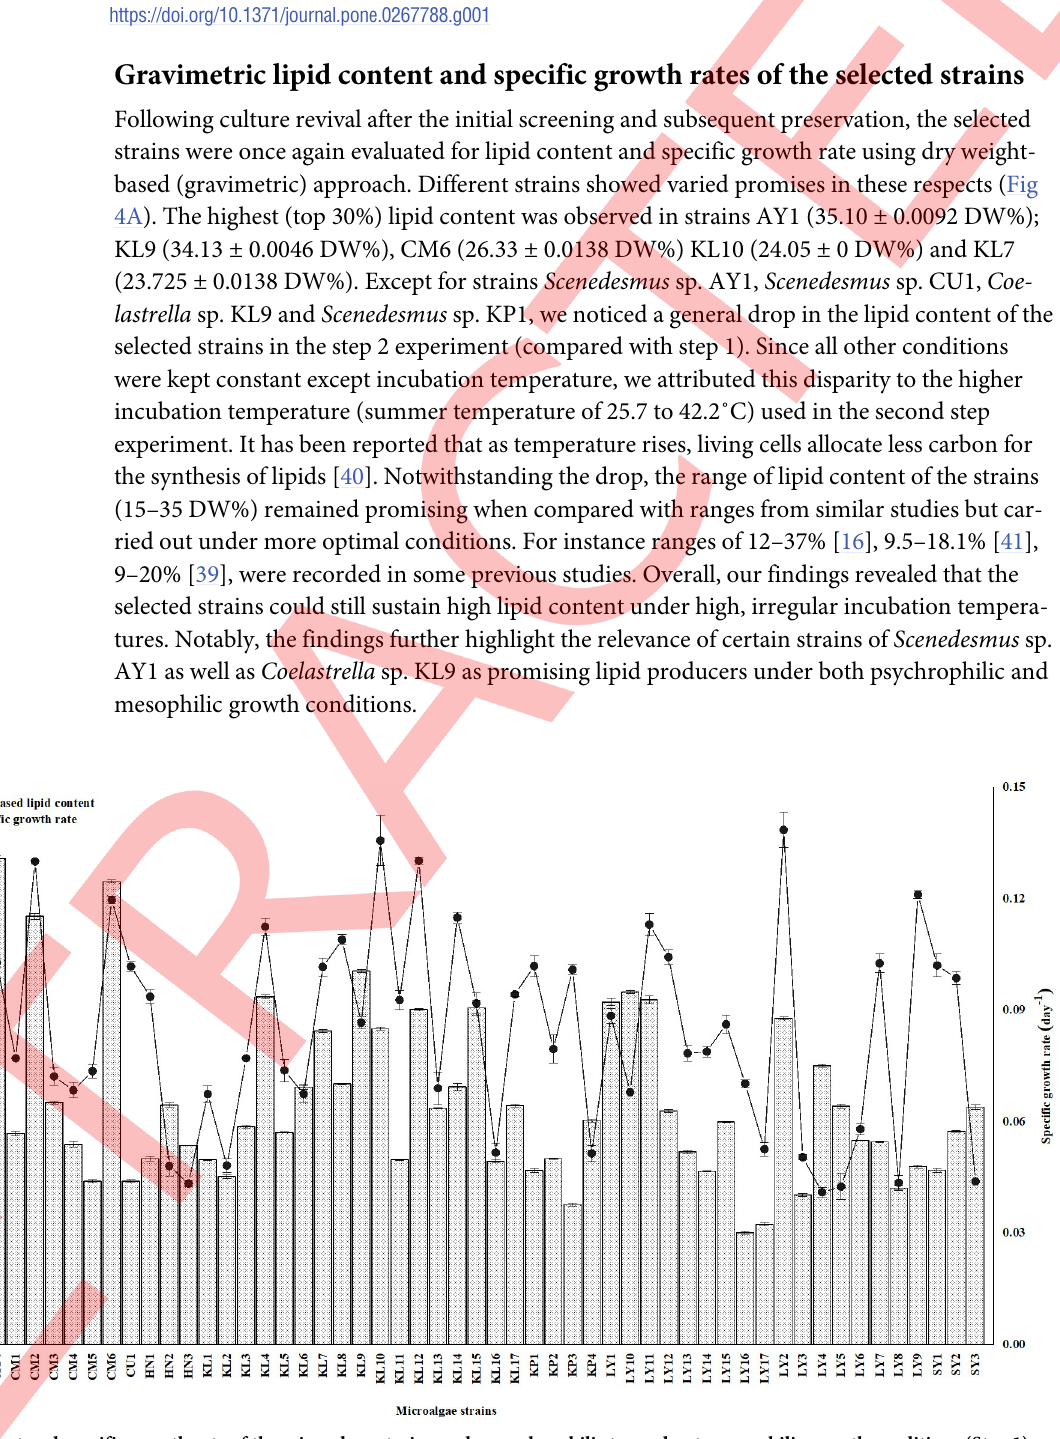
Fig 2. Lipid content and specific growth rate of the microalgae strains under psychrophilic to moderate mesophilic growth conditions (Step 1). Error bars indicate standard deviations of the replicate values for each strain.